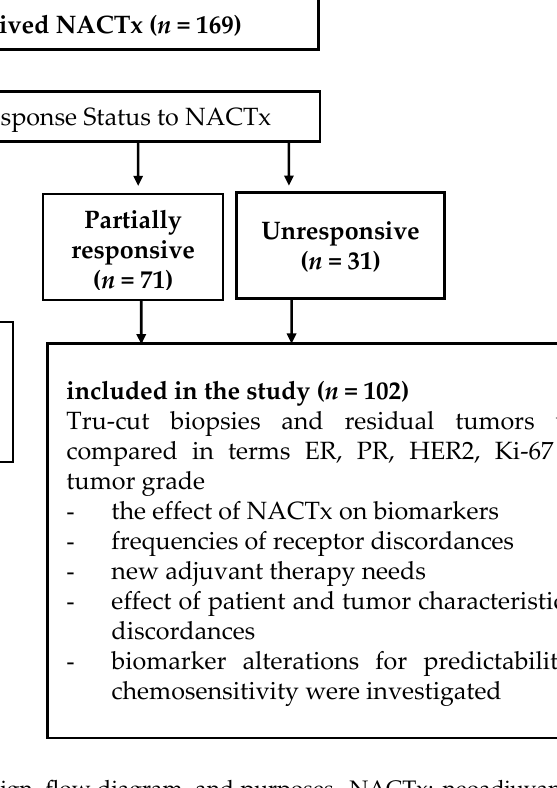
Figure 1. Study design, flow diagram, and purposes. NACTx: neoadjuvant chemotherapy; pCR: pathological complete response; MRD: minimal residual disease.